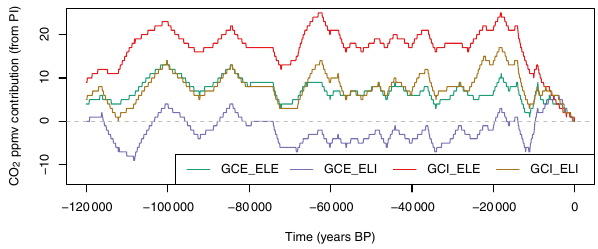
Figure 6. Contribution of terrestrial biosphere carbon emissions to atmospheric CO 2 . Run with the cGENIE “Full” configuration and normalised to pre-industrial CO 2 levels. The four scenarios are as detailed in Table